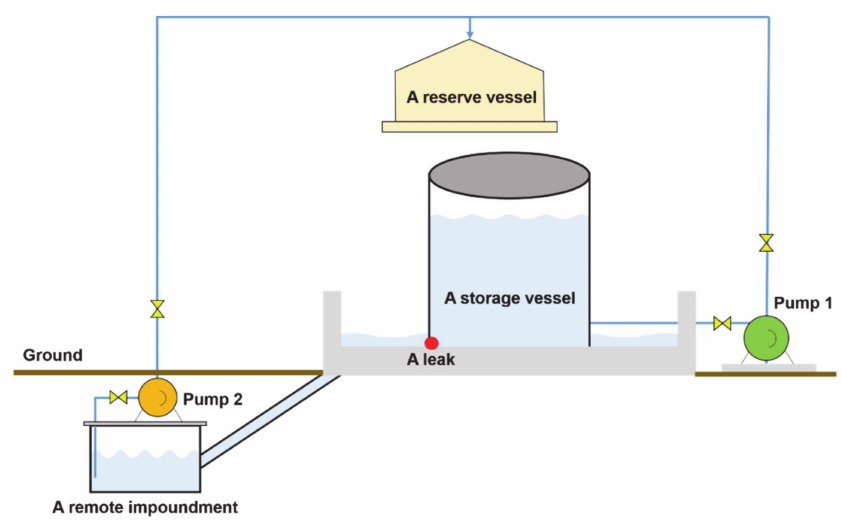
Figure 2. The diagram of a proposed mitigation system. A remote impoundment is installed under the